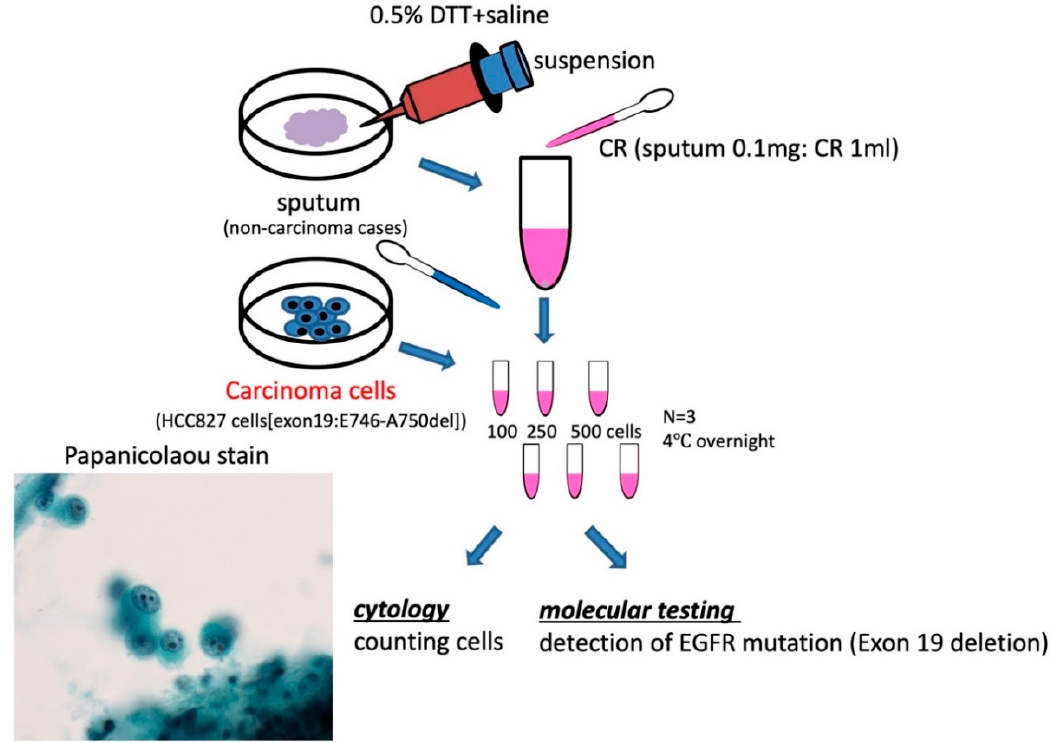
Figure 4. The treatment procedure for virtually positive sputum specimen of LBC (×400). (see materials and methods).